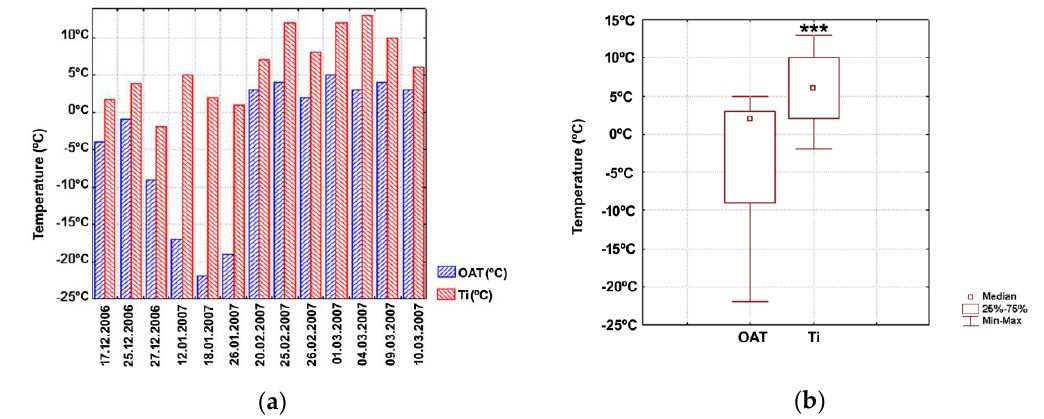
Figure 3. ( a ) Absolute values of ambient temperature and temperature for the pen protected with the “sandwich” system at selected time points. Data are shown as columns. ( b ) Median values for ambient temperature and temperature for the pen protected with the “sandwich” system. Data are shown as medians (point), with lower and upper quartiles (box) and minimum and maximum values (error bars). Marked boxes (*) indicate significant differences than the ambient temperature (Wilcoxon tests, ***— p ≤ 0.001, **— p ≤ 0.01, *— p ≤ 0.05). Ti, temperatures inside the “sandwich” system; OAT, ambient temperature.